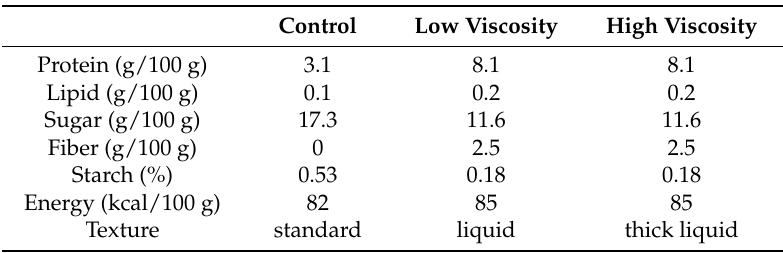
Table 1. Composition and texture of the three yogurts.